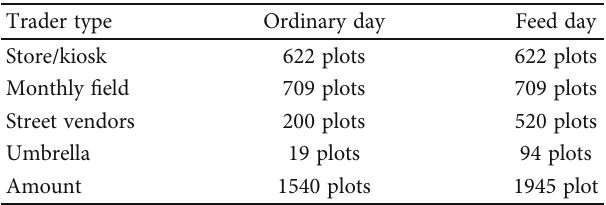
Table 2: Fluctuations in the number of Lower Market Traders on ordinary days and feed